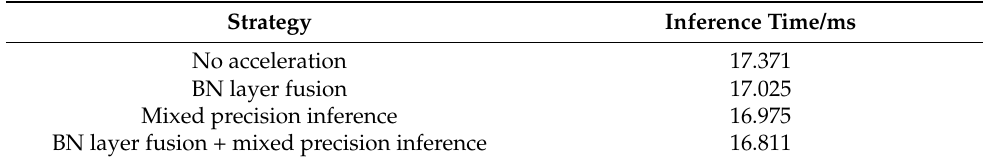
Table 4. The results of deployment